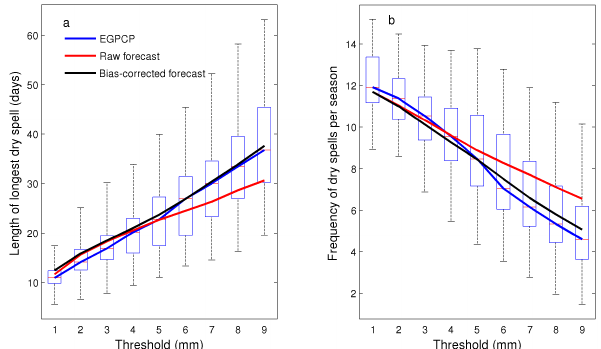
Figure 6. Effect of the threshold on (a) the length of dry spells and (b) frequency of dry spells for EGPCP, raw forecast and bias- corrected forecast for each season over the entire forecast period for lead time 0. The edges of the boxplot show the 25 and 75 quantiles; the whiskers indicate the maximum and minimum